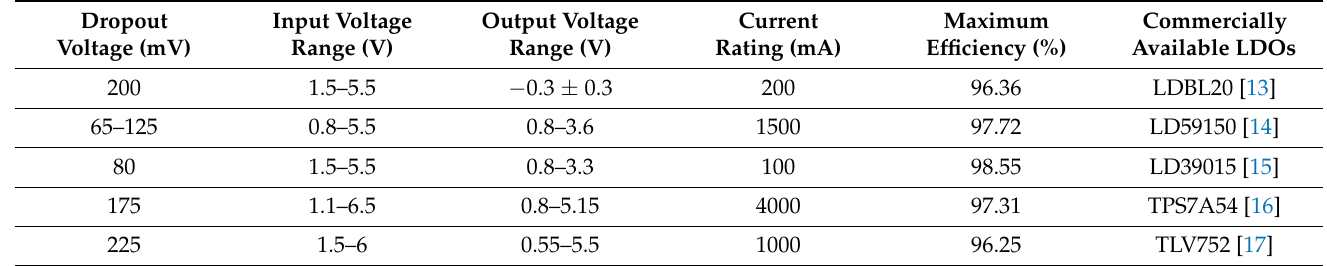
Table 2. Commercial ultra-low-dropout